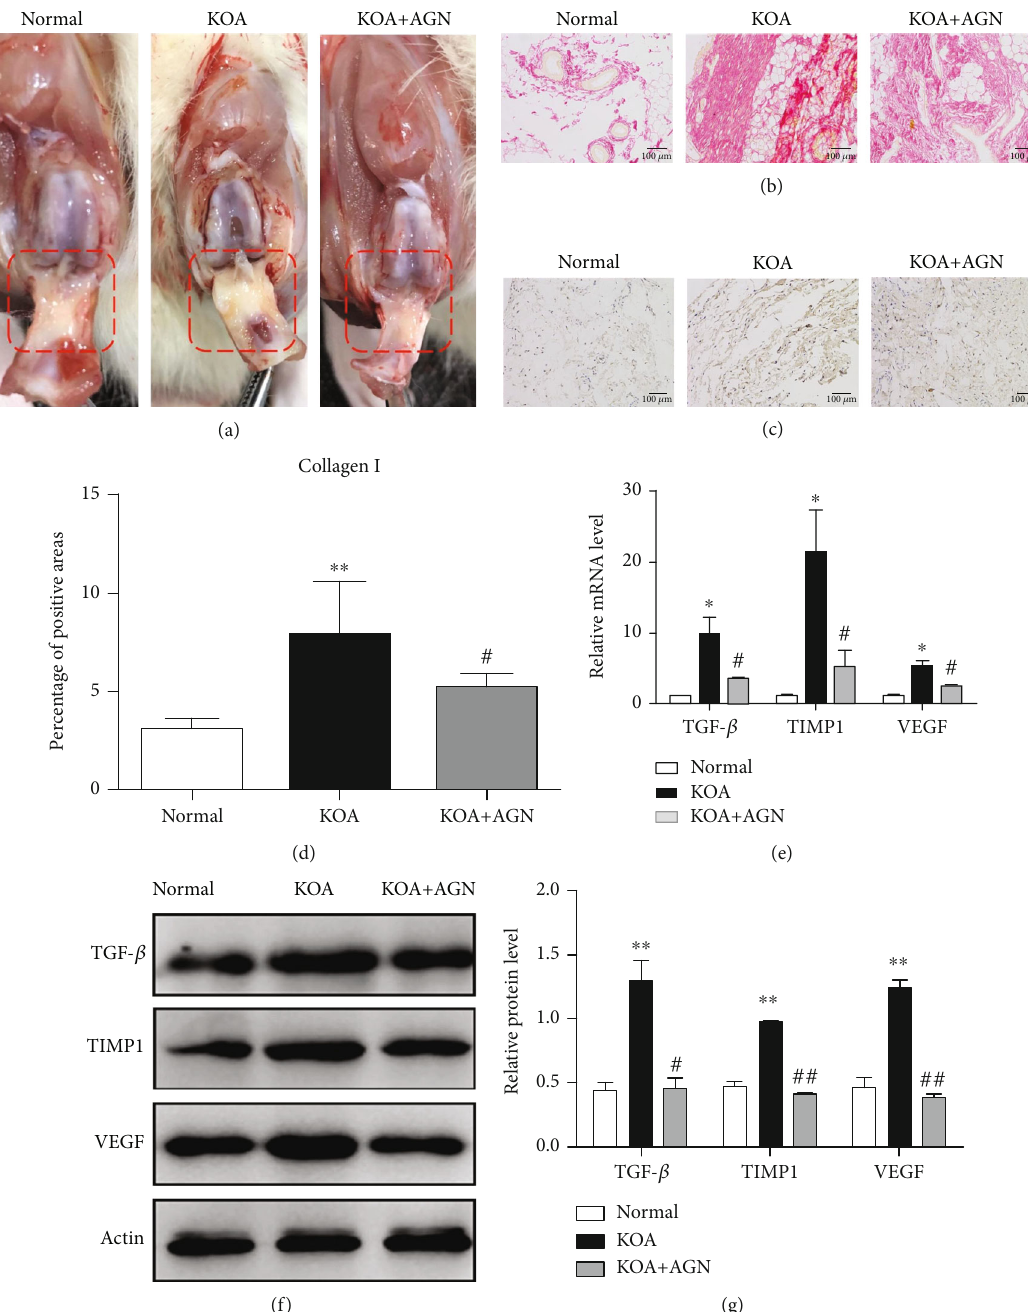
Figure 3: Agnuside alleviates synovial fi brosis in KOA rats. (a) Anatomical changes of synovial tissues (red box area) in each group. (b) Collagen deposition was revealed through Sirius Red staining, 200x, scale bar = 100 μ m. (c) Representative type I collagen immunohistochemical sections of synovial tissues in each group, 200x, scalebar = 100 μ m. (d) Semiquanti fi cation of immunohistochemical sections was evaluated by calculating the percentage of collagen I-positive areas. ∗∗ P < 0 : 01 , in comparison with the normal group. # P < 0 : 05 , in comparison with the KOA group. Data were analyzed by ImageJ. (e) Comparison of TGF- β , TIMP1, and VEGF mRNA levels between groups. ∗ P < 0 : 05 , compared with the normal group. # P < 0 : 05 , compared with the KOA group. (f) Typical protein bands for each group. (g) Comparison of TGF- β , TIMP1, and VEGF protein expressions between groups. ∗∗ P < 0 : 01 , compared with the normal group. # P < 0 : 05 , ## P < 0 : 01 , compared with the KOA